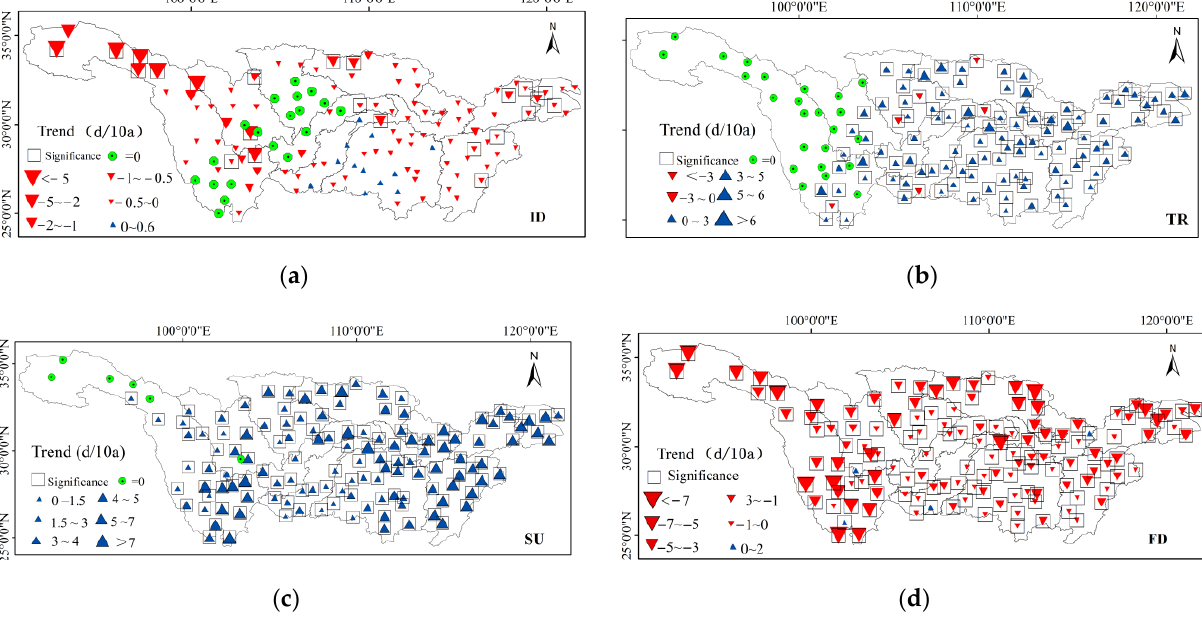
Figure 5. Spatial distribution of annual variation of absolute indices of extreme temperatures in the Yangtze River Basin from 1970 to 2014. ( a ) is ID, ( b ) is TR, ( c ) is SU and ( d ) is FD.